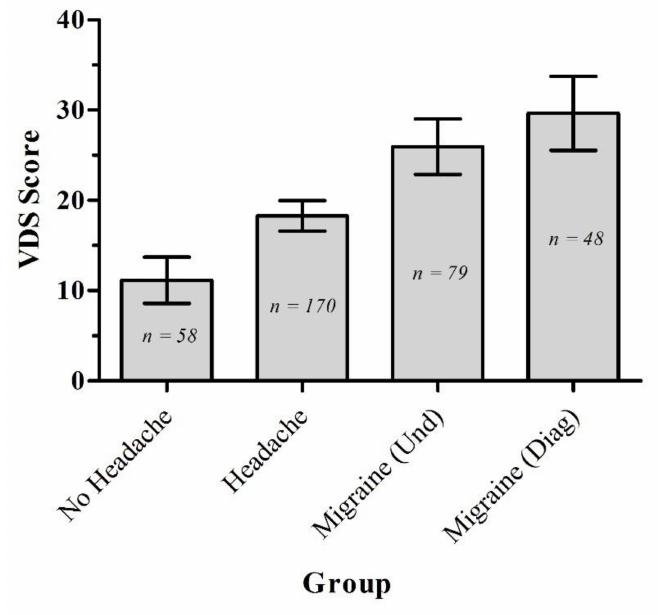
Figure 3. Mean VDS scores for each headache group, with the error bars representing 95% CIs.